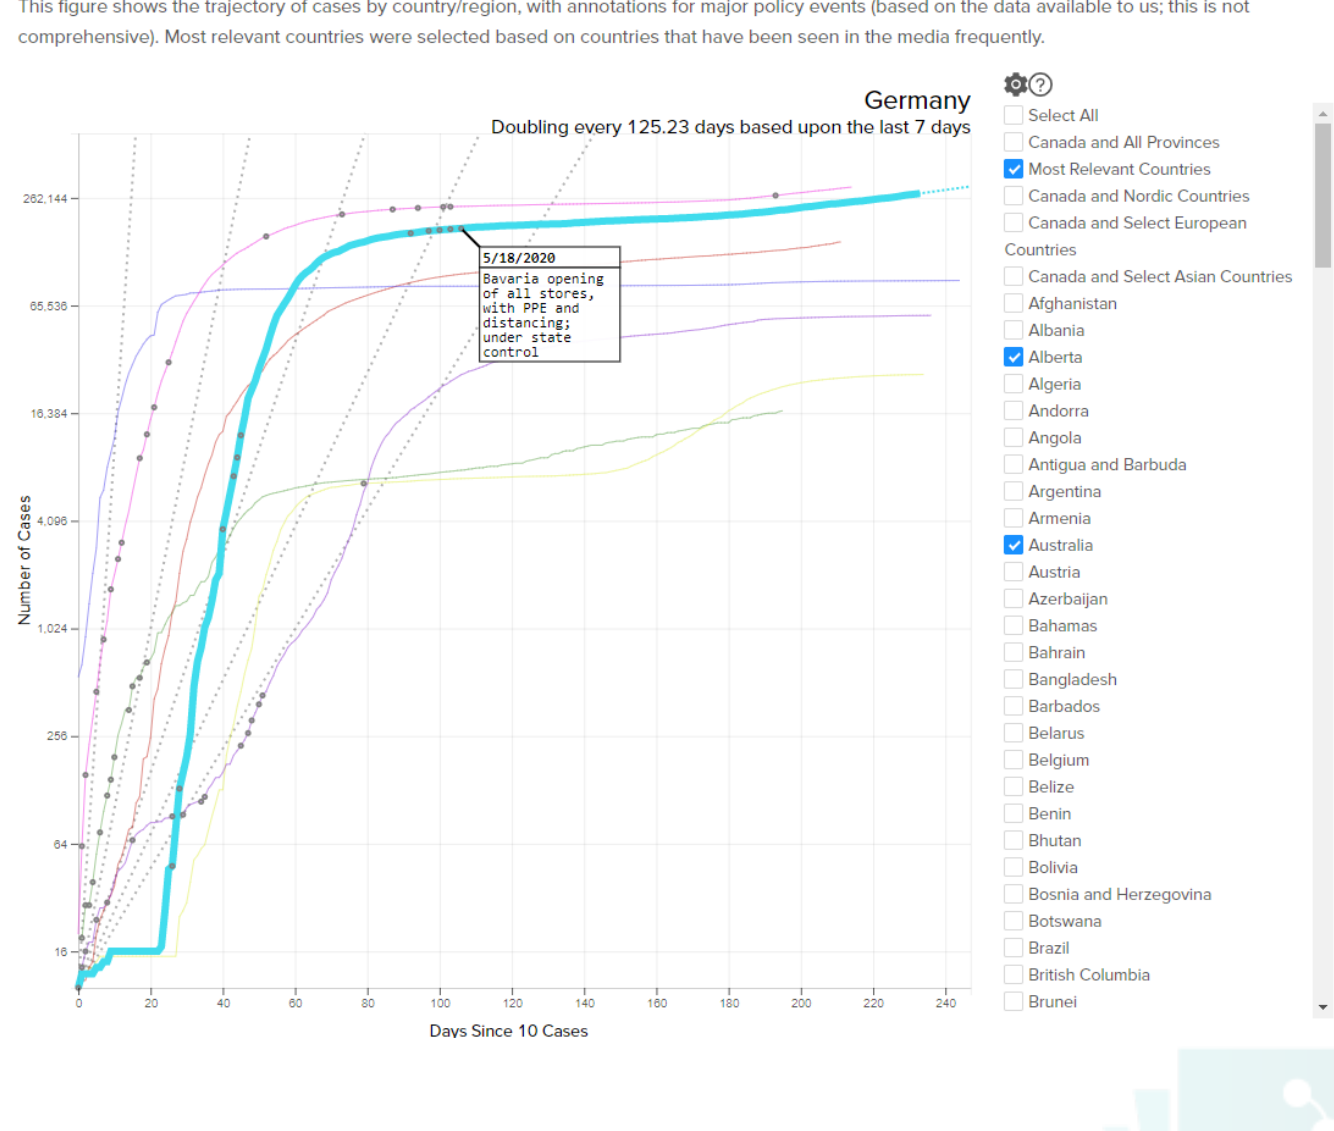
Figure 3: International Policy